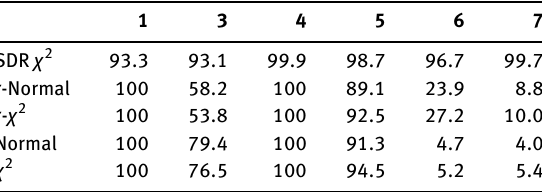
Table 3: Percentage of correct decision made by each test. “SDR χ 2 ” stands for the proposed χ 2 test, “r-Normal”, “r- χ 2 ”, “Nor- mal”, and “ χ 2 ” for the robust normal test, the robust χ 2 test, the ordinary normal test, and the ordinary χ 2 test in Crump etal. [11], respectively.